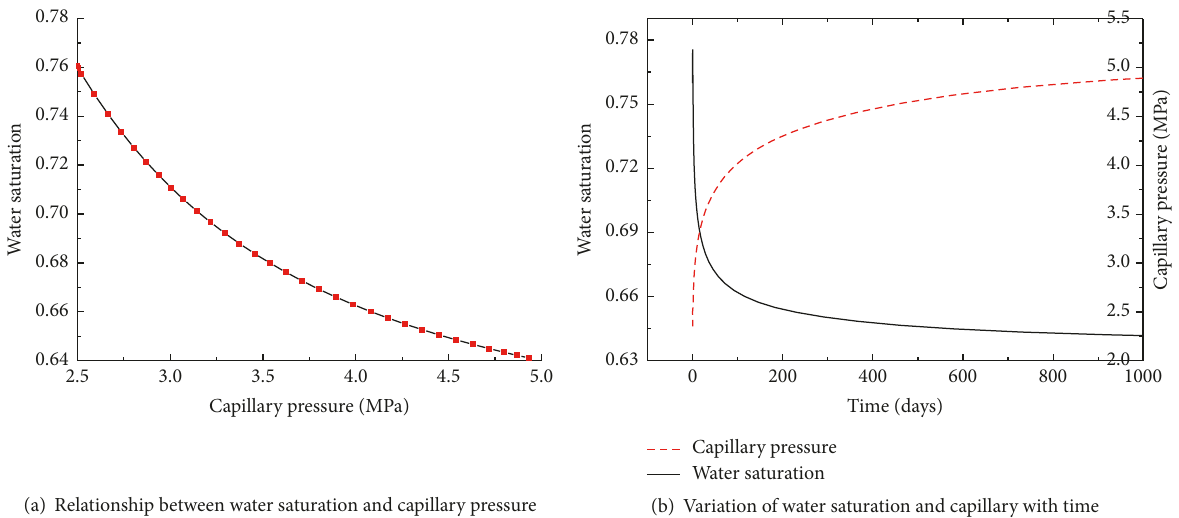
Figure 12: Change of water saturation and capillary with time at point A (36, 20) near the hydraulic